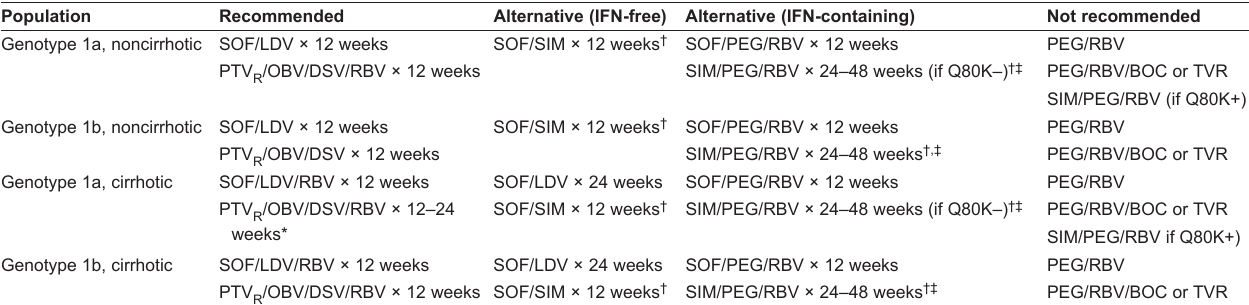
TABle 5 Treatment-experienced patients with hepatitis C virus (HCV) genotype 1 Population